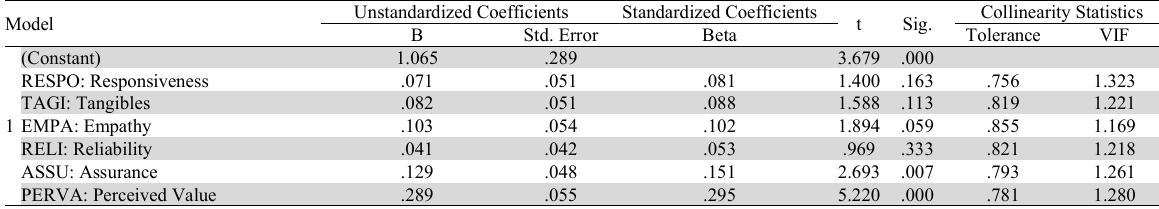
Regression analysis results of Customer